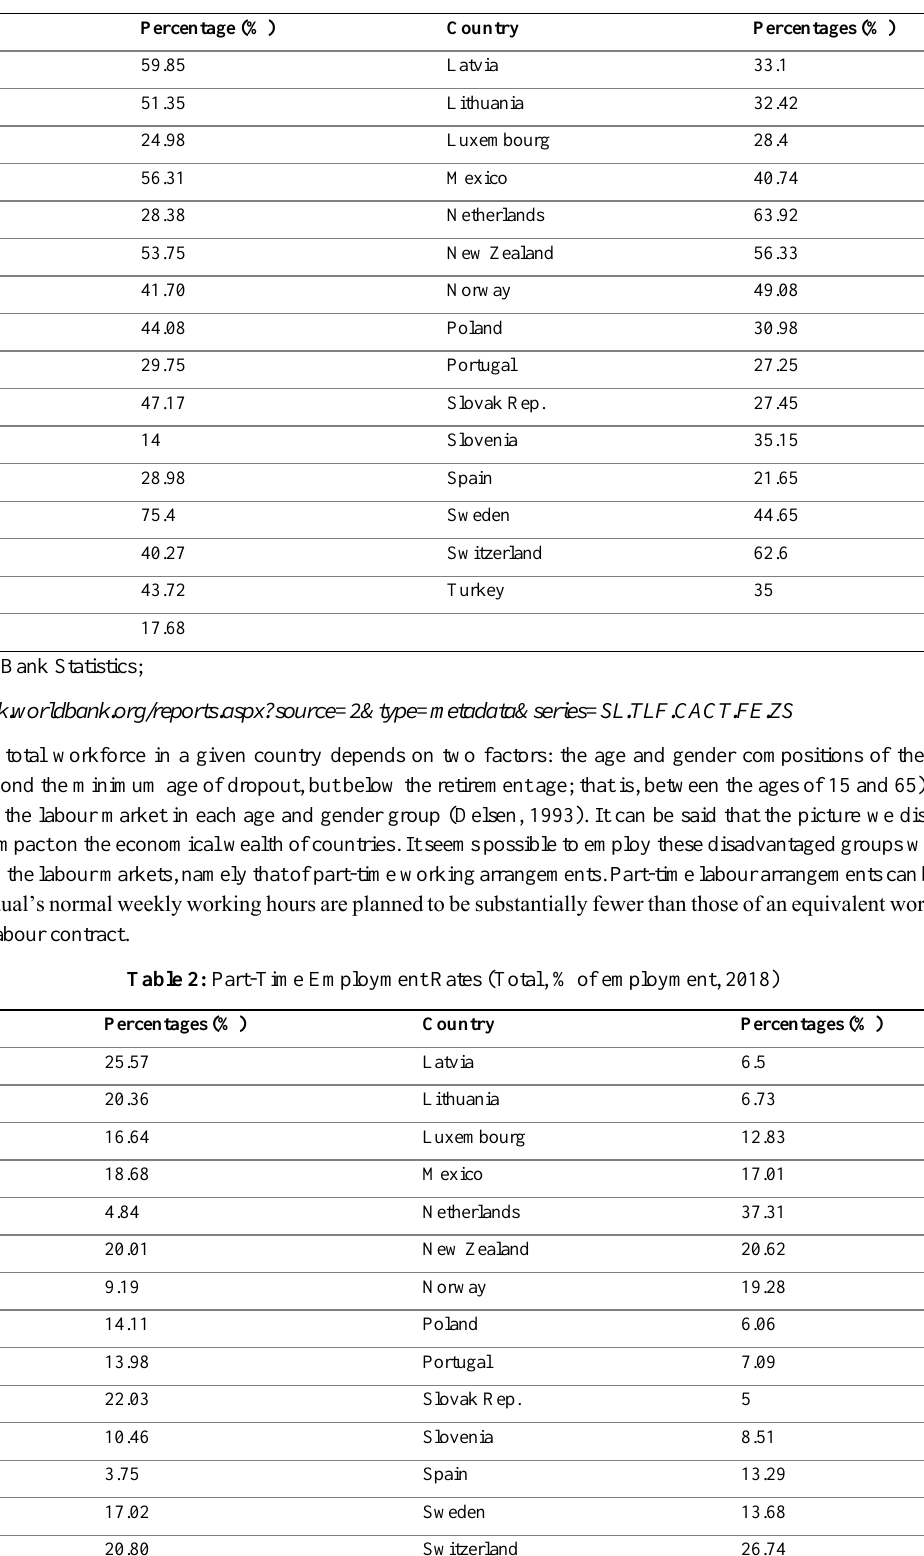
Table 1: Youth Employment Rates in 2018 in OECD countries